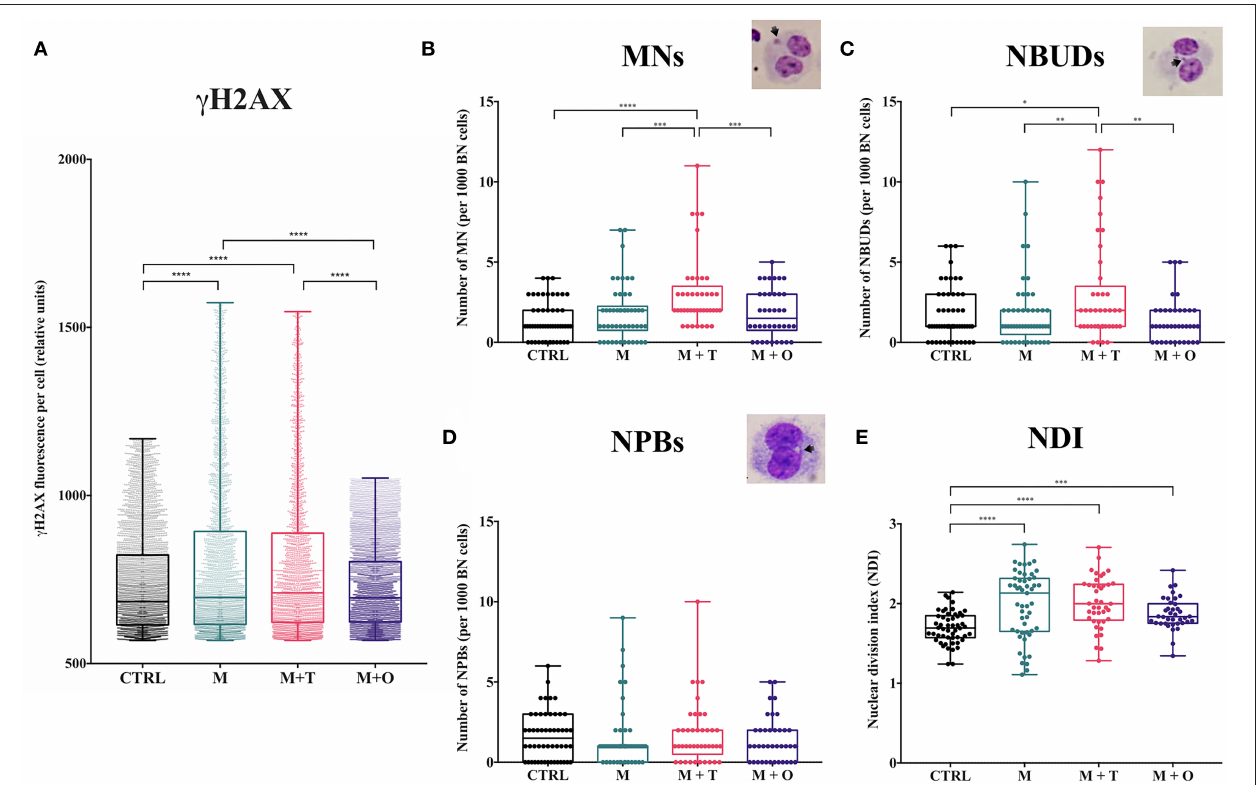
FIGURE 1 | Peripheral blood lymphocytes from marijuana mono-users and in combination with tobacco display the highest levels of genotoxic damage. (A) Comparison of the γ H2AX fluorescence intensity (FI) per cell from freshy isolated lymphocytes. The M and M + T groups show the highest γ H2AX FI, without significant differences between them. (B) Frequency of micronuclei (MN) in cultured peripheral blood lymphocytes. The highest number of cells with MN was observed in the M + T group in comparison to the other groups. Inset shows a representative binucleated cell with a MN. (C) Frequency of nuclear buds (NBUDs) in cultured peripheral blood lymphocytes. The highest frequency of NBUDs was found in the M + T group. Inset shows a representative binucleated cell with an NBUD. (D) Frequency of nucleoplasmic bridges (NPBs) in cultured peripheral blood lymphocytes. No differences were observed among groups. Inset shows a representative binucleated cell with an NPB. (E) Nuclear division index (NDI) in cultured peripheral blood lymphocytes The NDI is significantly increased in all marijuana users in comparison to the CTRL group. NDI was calculated by quantifying the number of mono, bi, tri, and tetranucleated cells and divided by number of viable cells scored (see Materials and Methods). Error bars indicate mean ± SD; a p -value = 0.01–0.05 was considered significant (*), a p = 0.01 to 0.001 was considered very significant (**, ***) and a p < 0.001 was considered extremely significant (****).